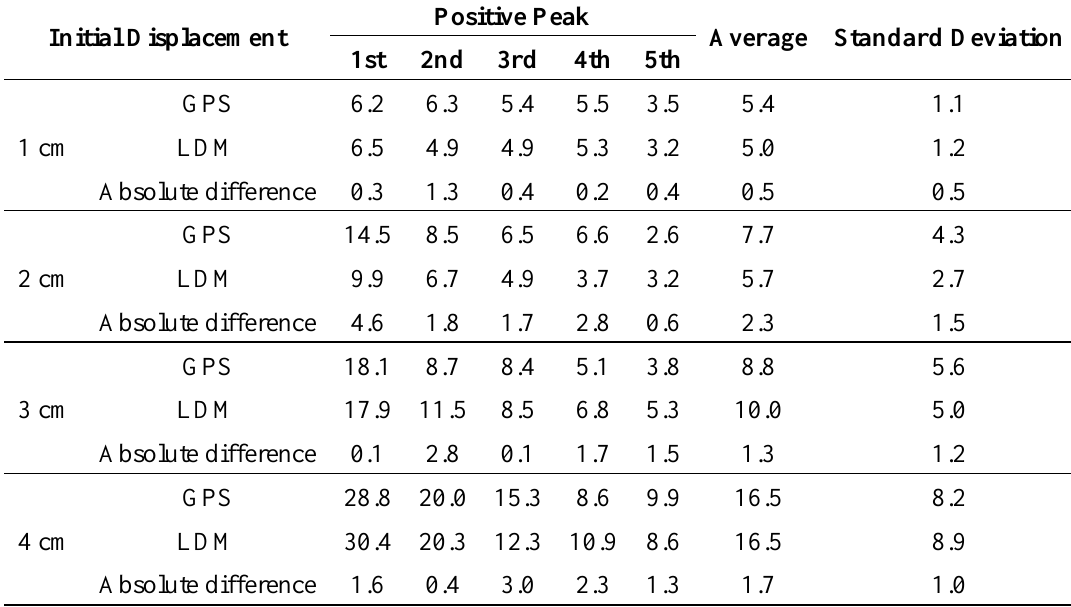
Table 1. Absolute difference between values (in mm) measured by the GPS and the laser displacement meter